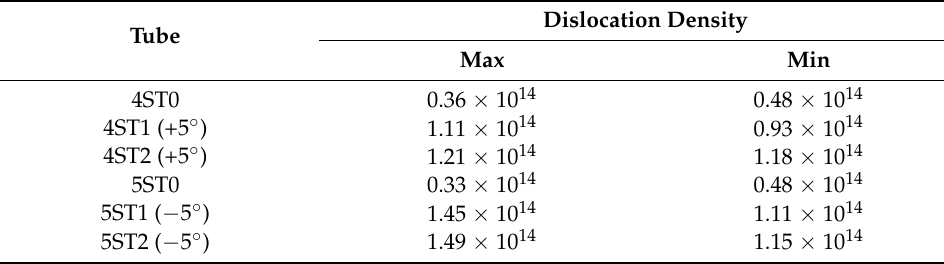
Figure 17. Dislocation density estimation for the Cu tube at different deformation steps. Table 7. The dislocation density estimation for Cu tube.